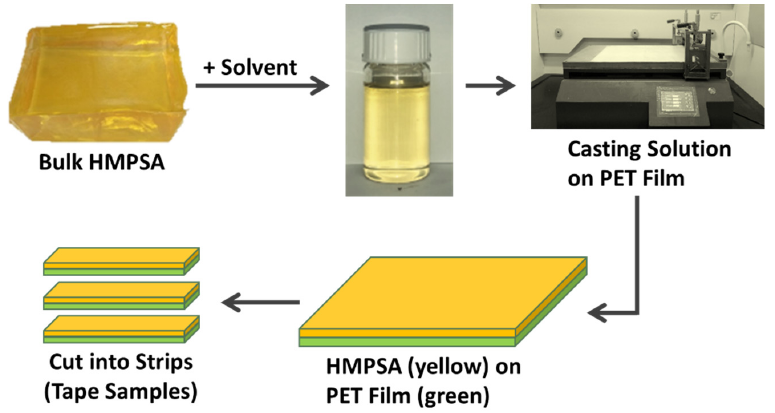
Figure 1. Process for tape sample preparation through casting solution method.